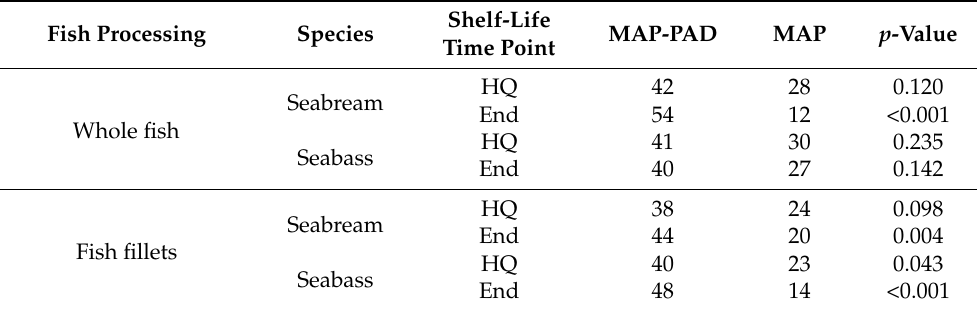
Table 3. Consumer preference results presented as frequencies ( n ). p -values were calculated by applying a binomial test at a =